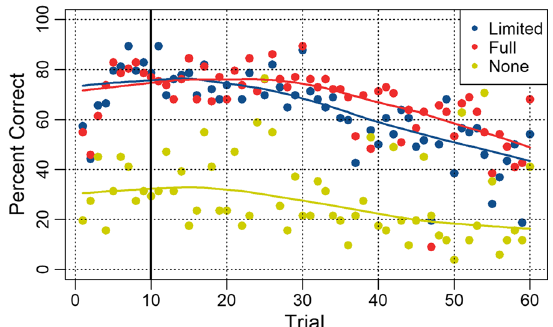
Fig. 4 Percentage of participants who responded correctly per trial in Study 2 and 3. Note. Limited-feedback and full-feedback conditions are from Study 2, No-feedback condition is from Study 3. The solid vertical line indicates trial 10, after which feedback only continues for the full-feedback